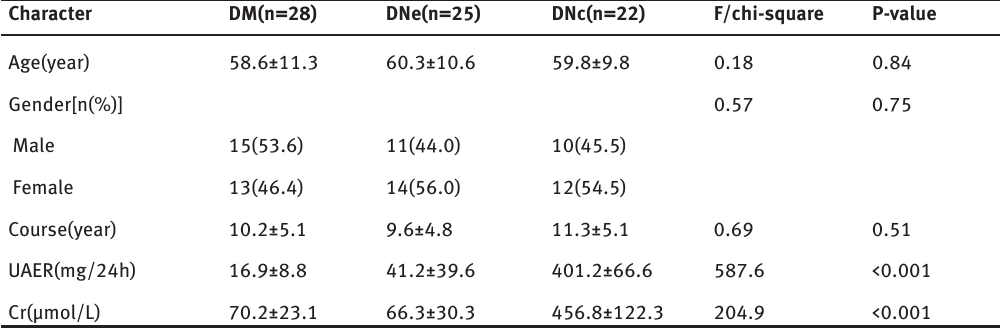
Table 1: The baseline characteristics of the included cases for type 2 diabetes mellitus and diabetic nephropathy.